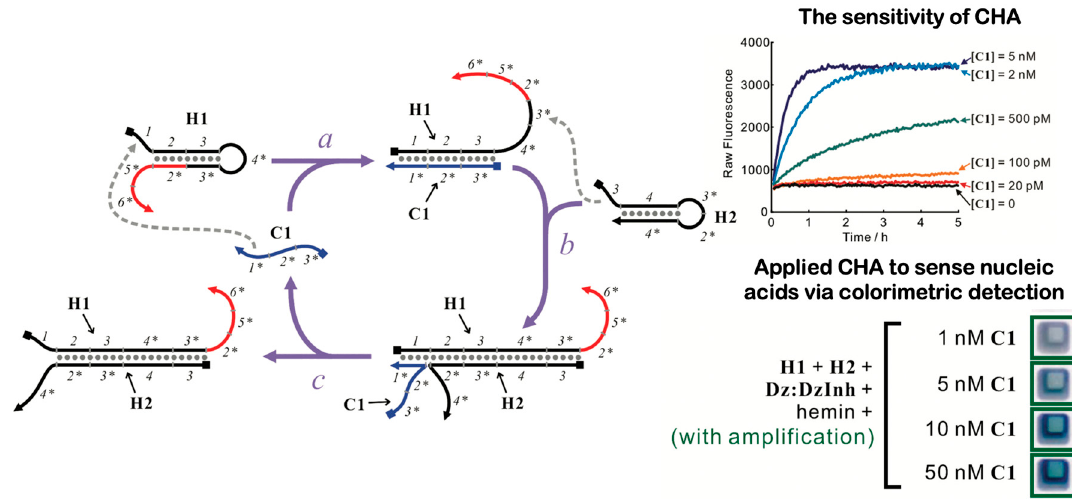
Figure 11. Principle of DNA catalytic hairpin assembly amplification (CHA): Basis mechanism involved two meta-stable DNA hairpins and a target initiator. Upon sensing the presence of the initiator, the hairpins autonomously cycle through the cascade reaction, producing exponential DNA output signals through either FRET or colorimetric analyses. Adopted with permission from [176].